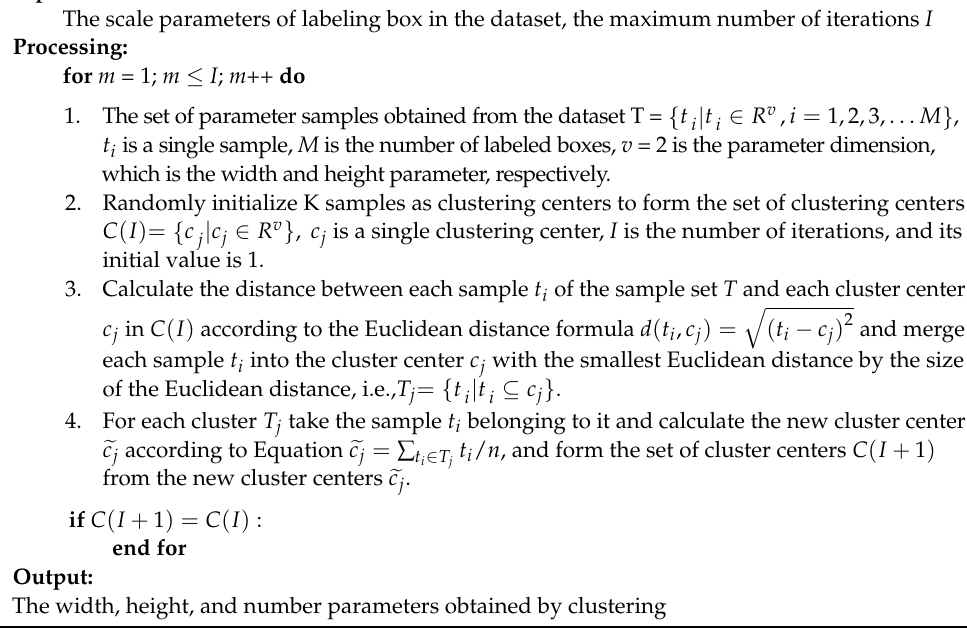
Algorithm 1 Overall process of anchor-box scale